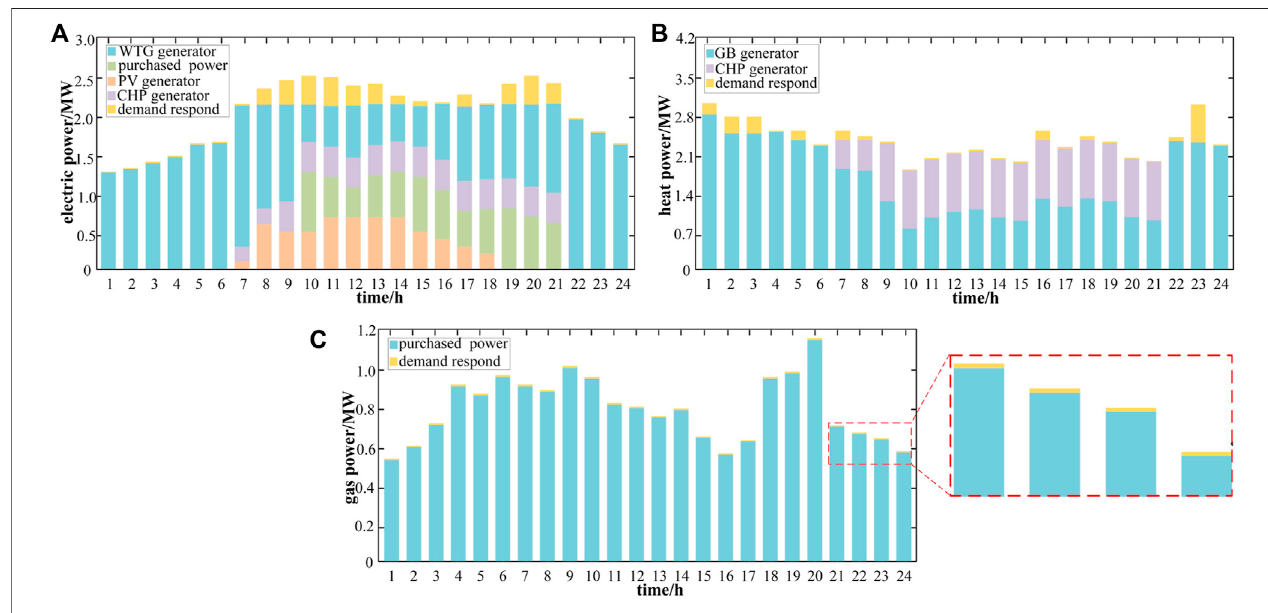
FIGURE 10 | Device optimization